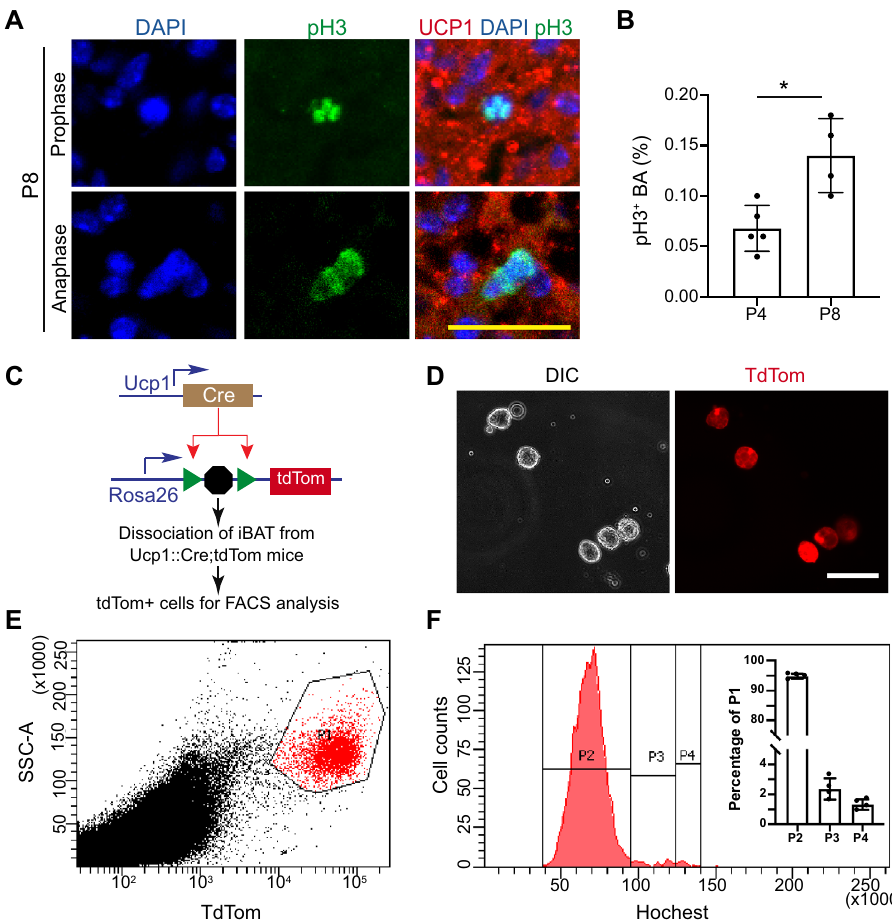
Figure 4. Detection of proliferating BAs in the neonatal mice. ( A) Representative immunofluorescence images of iBAT. Bar = 25 µm. P8: postnatal day 8. pH3: phospho-Histone H3 (Ser10). ( B) Quantification of pH3 positive brown adipocytes at postnatal day 4 and day 8. Student t test, * P < 0.05. Each datum point indicates one individual animal. ( C ) Experimental design for FACS analysis. In the Ucp1::Cre; Rosa 26 tdTom mice, BAs were genetically labeled with tdTomato (tdTom) fluorescence protein. BAs from dissociated iBAT were used for FACS analysis. ( D) Representative images of dissociated BAs. Bar = 50 µm. ( E,F ) FACS analysis of BAs. iBAT from P8 Ucp1::Cre; Rosa 26 tdTom mice were dissociated and stained with Hochest. E. tdTom + BAs gating image. ( F ) DNA content histogram of gated tdTom + BAs. tdTom + BAs (Population 1, P1) were separated into three populations based on DNA contents: P2, P3, P4, representing BAs at G0/G1, S and G2/M phases, respectively. The cell number of P2, P3, and P4 was normalized to the number of gated TdTom + BAs (P1), and calculated percentages were shown in the inset bar graph. N =